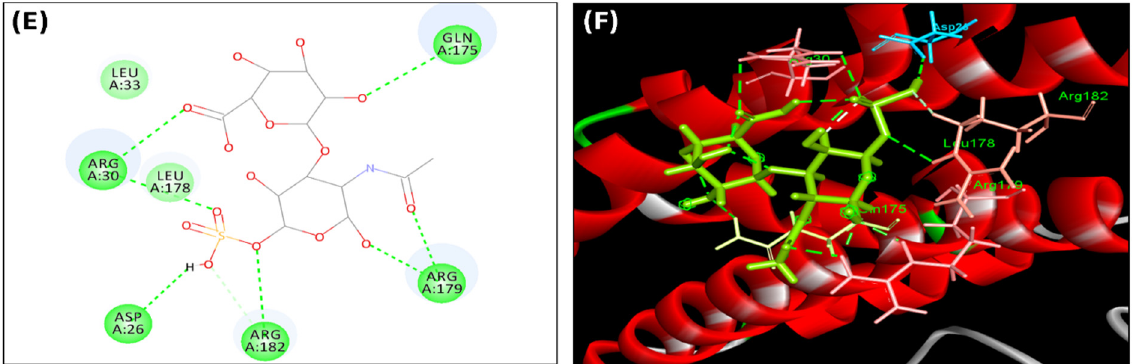
Figure 6. Interactions of chondroitin sulfate with active site of TNF-alpha pocket (2AZ5): ( A ) 2D interactions; ( B ) 3D interactions. Interactions of chondroitin sulfate with active site of IL-1 β (1ITB) pocket: ( C ) 2D interactions; ( D ) 3D interactions. Interactions of chondroitin sulfate with active site of IL-6 (1ALU) pocket: ( E ) 2D interactions; ( F ) 3D interactions. The hydrogen bonds are indicated with green dashed lines, and the van der Waals forces are in white.